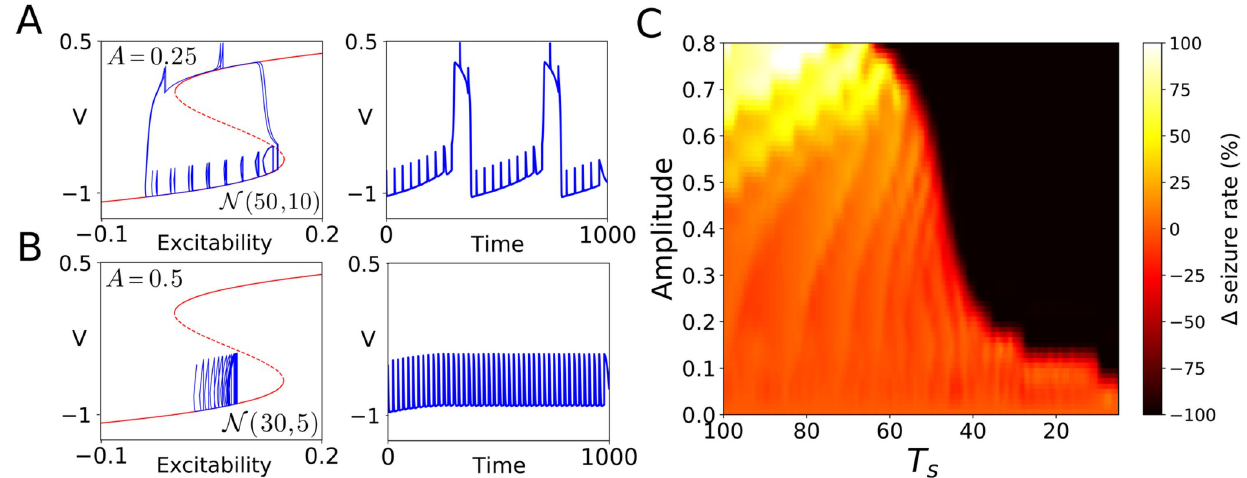
Fig 2. The antagonistic effect of IEDs on the transition to seizure. Panels A and B show, in red, the v-nullcline whose stable branches correspond to the stable low and high activity states of the system. The unstable part of the v-nullcline (dashed red line) separates the basin of attraction of both branches. As was illustrated in [22], Figure 5, whether the pulses make the system cross the unstable part of the v-nullcline determines the opposite nature of IEDs. For a random train with amplitude A = 0.25 and t � N ð 50 ; 3 2 Þ the system goes to seizure (panel A). By contrast, for a random train with amplitude A = 0.5 and s � N ð 30 ; 2 2 Þ the system avoids the seizure state (panel B). By plotting the change in seizure rate Δ as a function of both the amplitude, A , and the mean t s inter-perturbation interval, T s (panel C), we can distinguish between pro-convulsive regimes (yellow and white areas) in which the transition is potentiated, and preventive regimes (red and black areas) in which the transition is delayed or completely suppressed. We refer the reader to Materials and Methods section for the specific details about the computation of panel